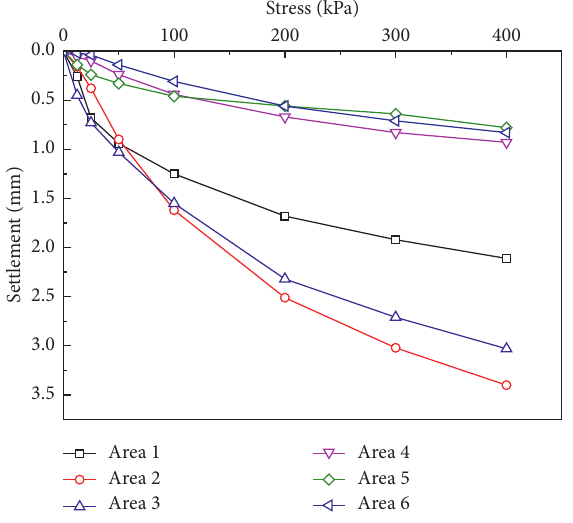
Figure 9: Result of the compaction test.